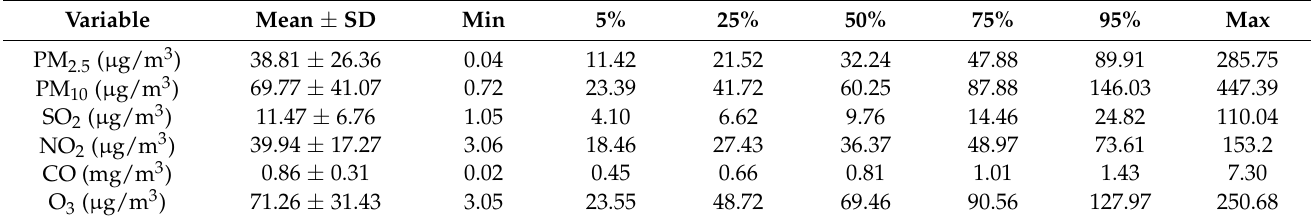
Table 2. The distribution of exposure to ambient air